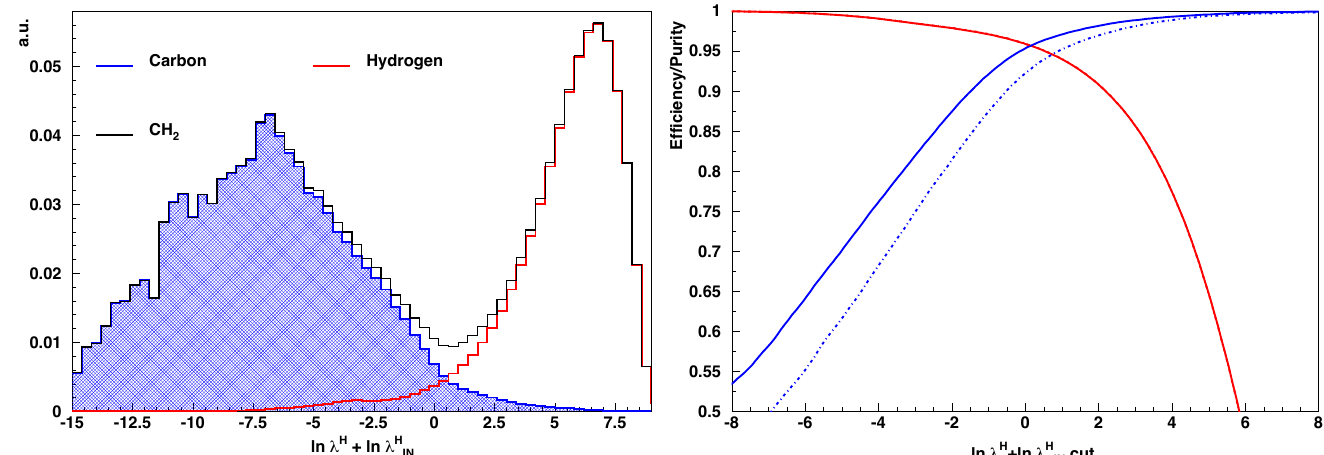
Figure 140. ( Left ): Example of kinematic identification of ν ( ¯ ν ) H interactions for the ν µ p µ − p π + CC topologies → reconstructed in the STT. The distributions of the logarithm of the likelihood ratio H/C for the H signal, the C background, and the CH 2 plastic (sum) are shown. ( Right ): Efficiency (red color) and purity (blue color) as a function of the kinematic µ − p π + (solid lines) and ¯ ν µ p µ + p π − (dashed-dotted lines) on H cut for the exclusive processes ν µ p → →